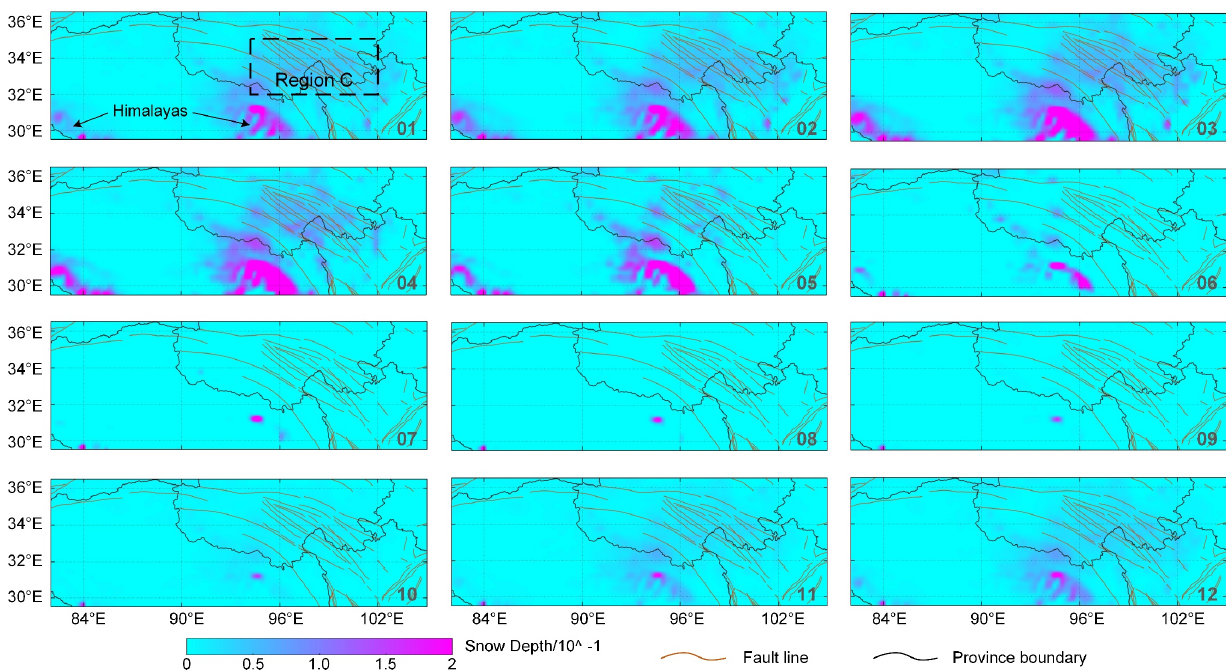
Figure 6. The quantitative results on snow depth and other multiple parameters in region C are shown in Appendix A Figure A2.